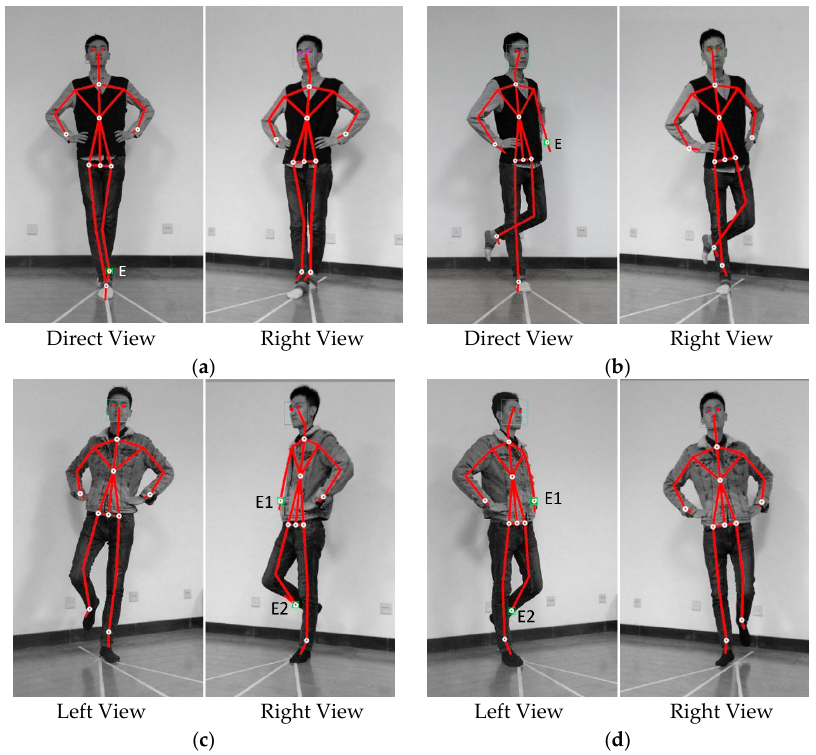
Figure 4. Representative self-occlusion images in direct, left or right view of Kinect sensors. ( a ) in the direct view, the rear ankle joint E is occluded whereas not in the right view; ( b ) in the direct view, the left wrist joint E is occluded when the body twisted, whereas not in the right view; ( c ) in the right view, the joints E1 and E2 are occluded, whereas not in the left view; ( d ) in the left view, joints E1 and E2 are occluded whereas not in the right view.